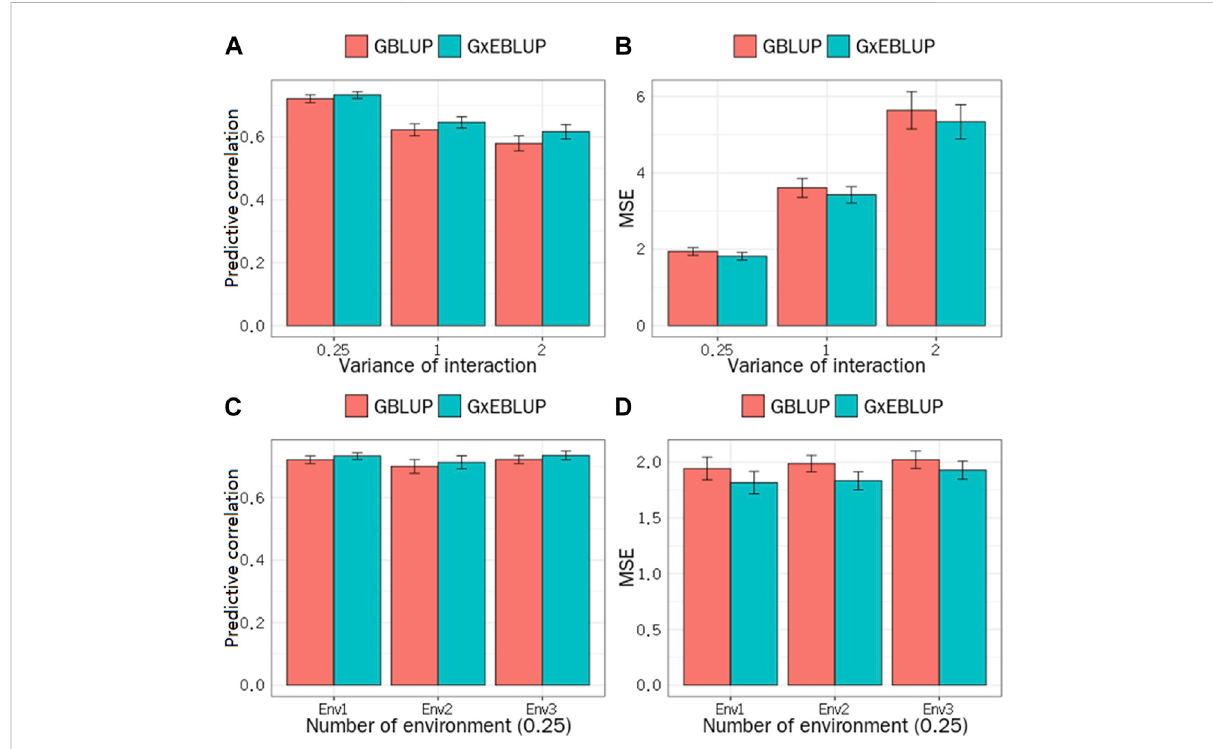
FIGURE 2 GBLUP and G × EBLUP method for the (A) accuracy and (B) mean squared error (MSE) of genomic prediction under different G × E interaction variances. Genomic prediction (C) accuracy and (D) MSE under different numbers of environment